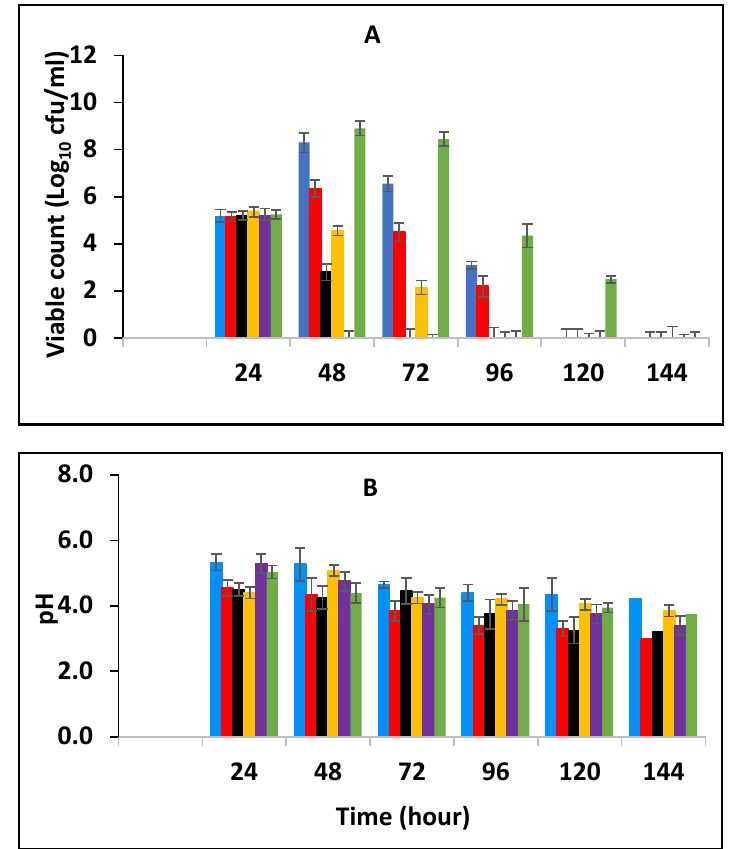
Figure 5. Survival of E. fergusonii ( A ) and change in pH ( B ) in the presence of essential oils of black pepper (BPE) and cinnamon extracts (CE) during storage at 25 ° C of yoghurt fermented at 25 ° C for 24 h. The EOs were added at different concentrations post milk fermentation. Concentrations are in % ( w / v ), values are the mean of three individual replicates (means ± SD). Control [ ]; 0.5% BPE alone [ ◼ ] ; 0.1875% CE + 0.125% BPE [ ◼ ]; 0.125% CE + 0.25% BPE [ ◼ ]; 0.0625% CE + 0.375% BPE [ ◼ ]; 0.25% CE alone [ ◼ ].